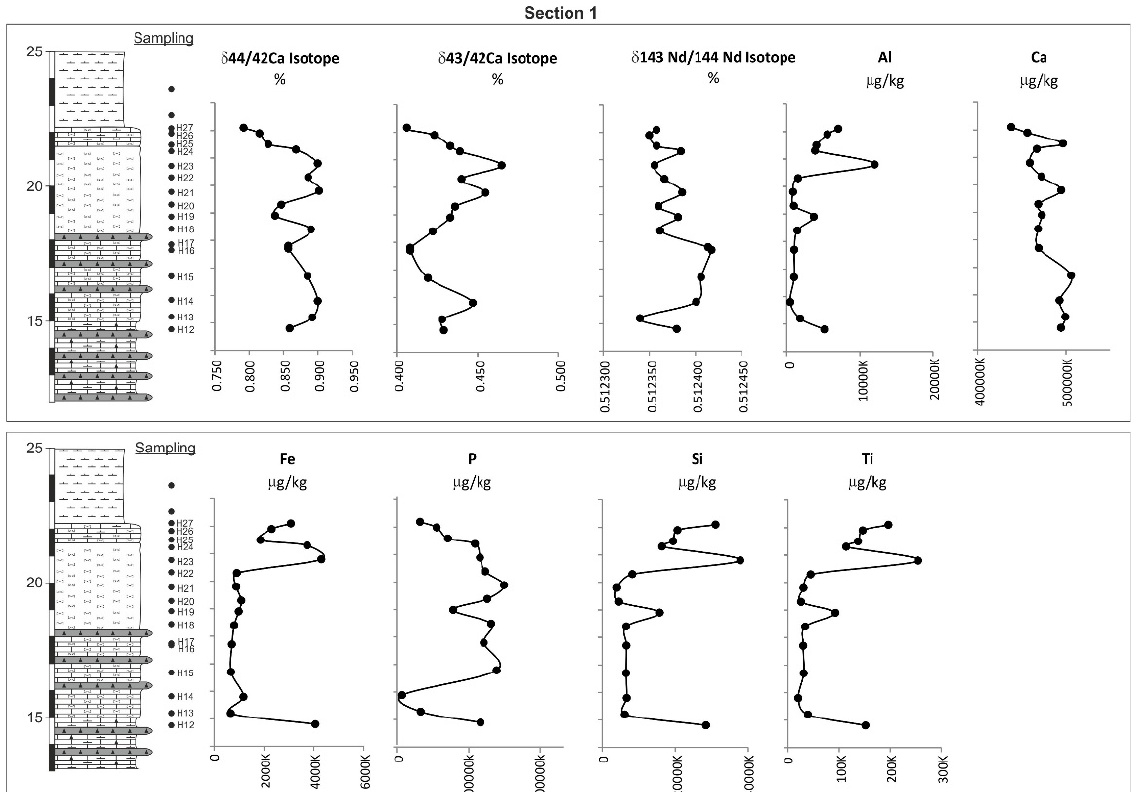
Figure 6. Geochemical data plot against its stratigraphic positions of samples 1.